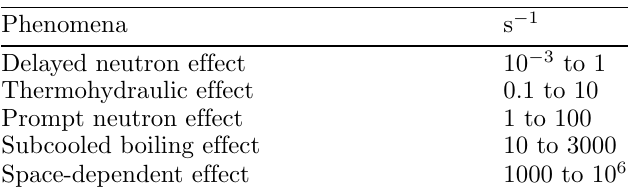
Table 1. Time constants of fluctuation phenomena in light water reactors (after